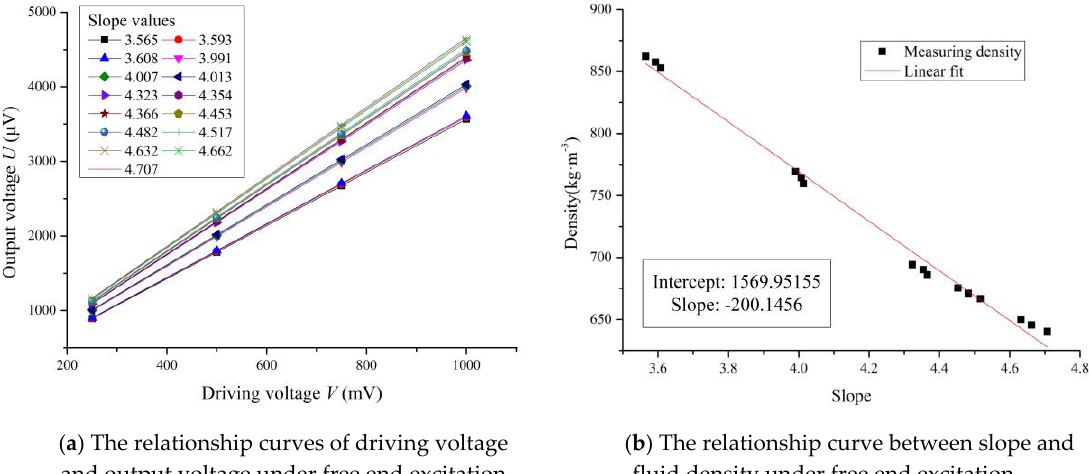
Figure 10. The measuring curves under free end excitation.